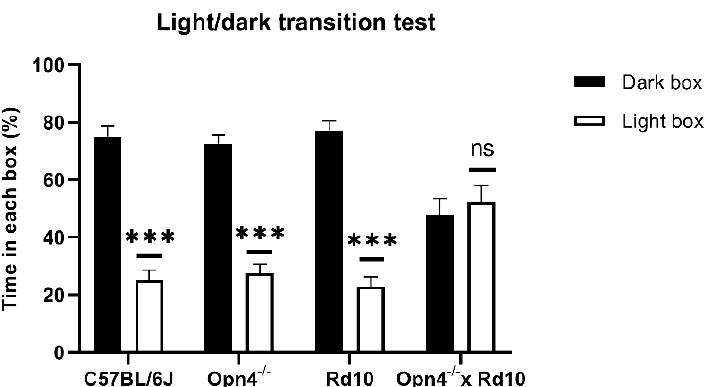
Figure 1. Percentage of time spent by each animal model (C57BL/6J, n = 8; Opn4 − / − n = 8; Rd10, n = 8; Opn4 − / − × Rd10, n = 8), in each of the compartments of the light/dark transition test. Histograms in black correspond to time spent in the dark compartment, and white histograms, the time spent in the illuminated compartment. The Opn4 − / − × Rd10 animal model is not capable of differentiating between the two compartments, unlike the rest of the animal models, which have longer stays in the dark compartment. Data are presented as the mean ± SEM. (***, p < 0,001; ns, not significant). Unlike the rest of animal models, the O × Rd double mutants ( n = 8), which do not have any type of photosensitive element in their retinas, are therefore not capable